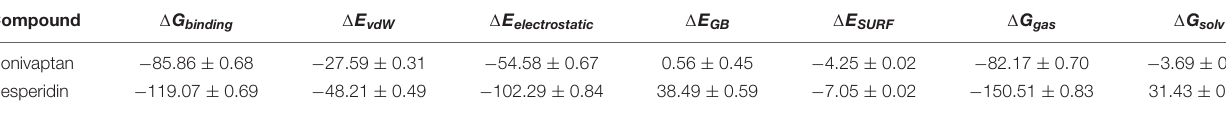
TABLE 3 | Binding free energy (kcal/mol) calculation of drug molecules against ExoN. Compound (cid:49) G binding (cid:49) E vdW (cid:49) E electrostatic